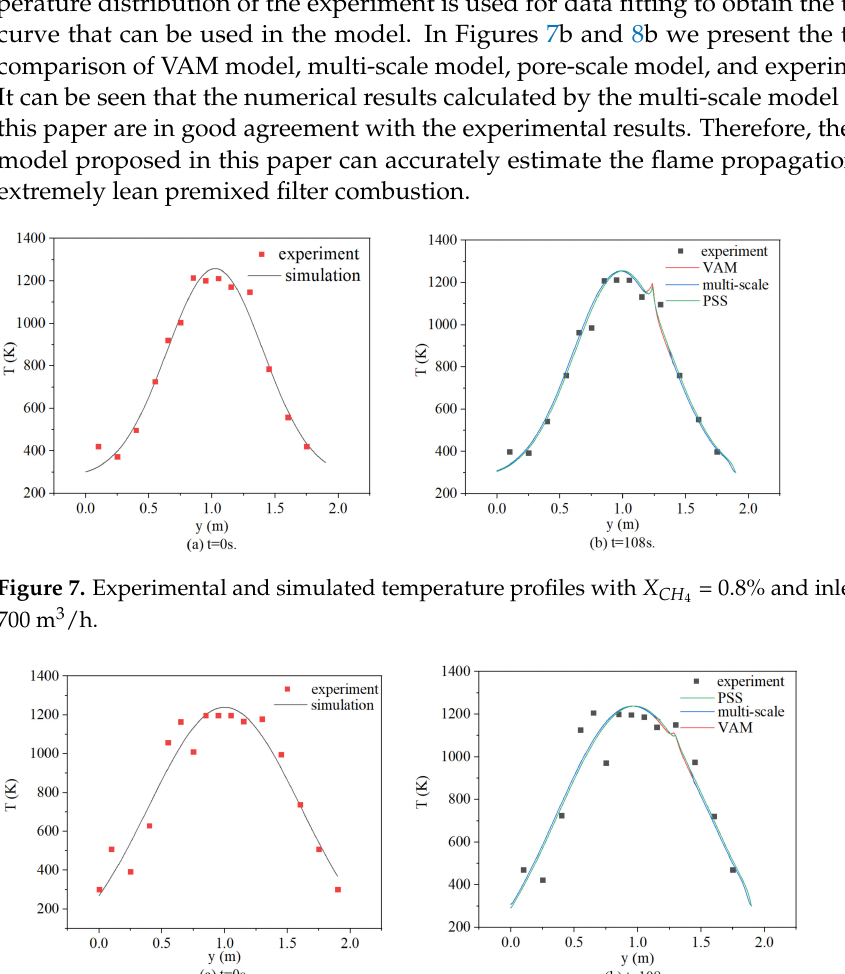
Figure 8. Experimental and simulated temperature profiles with X CH 700 m 3